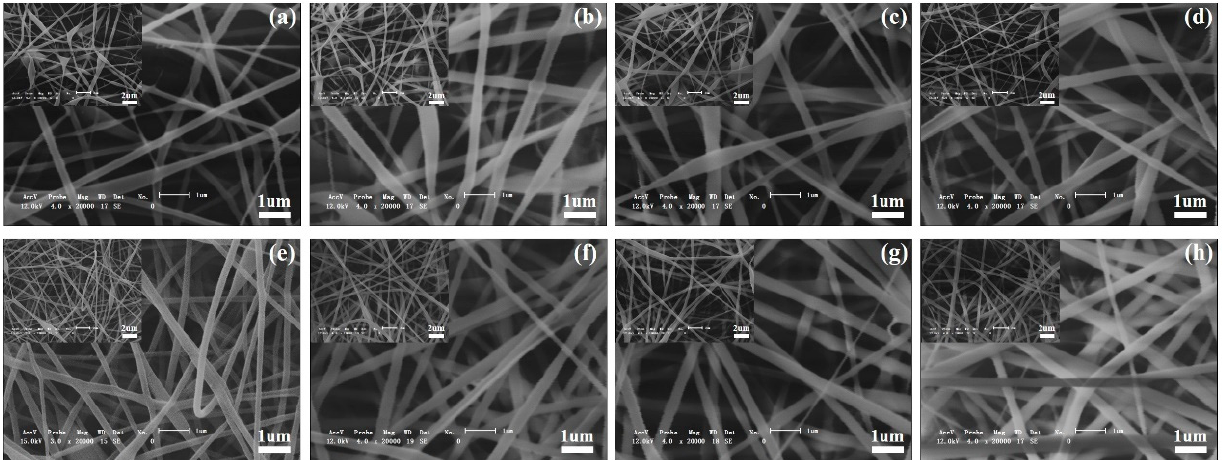
Figure 10. SEM images of nano fi bers under di ff erent condition. ( a ). PVA/TFP/PL(5:1:1); ( b ). PVA/TFP/PL(6:1:1); ( c ). PVA/TFP/PL(7:1:1); ( d ). PVA/TFP/PL(8:1:1); ( e ). PVA/TFP-SPI/PL(5:1:1); ( f ).